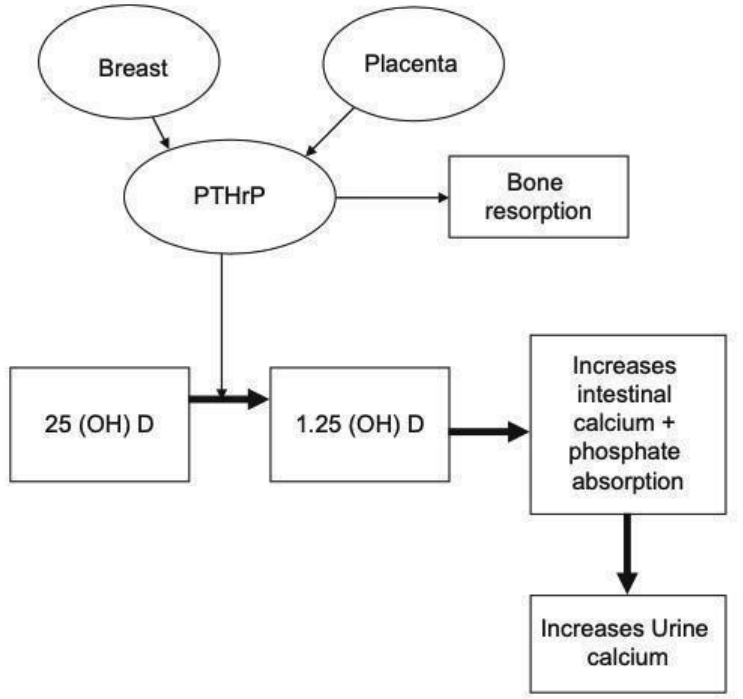
Figure 1. Calcium homeostasis during pregnancy (Reproduced with permission from Khan et al. EJE 2019) [59].